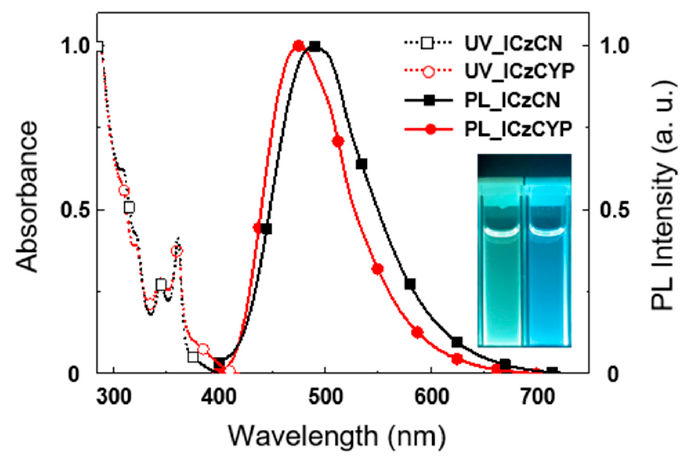
Figure 2. UV-Vis absorption and PL spectra of ICzCN and ICzCYP in toluene at room temperature. (inset: luminescence of ICzCN (left) and ICzCYP (right) in toluene.). Table 1. Photophysical properties of ICzCN and ICzCYP emitters.